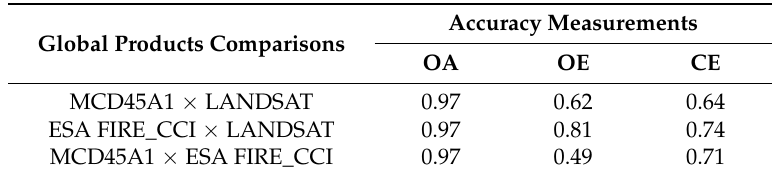
Table 3. Overall accuracy (OA), Omission error (OE) and Commission error (CE) between pair-wised global remote sensing products MODIS MCD45A1, ESA FIRE_CCI and the reference local burned area dataset from LANDSAT.